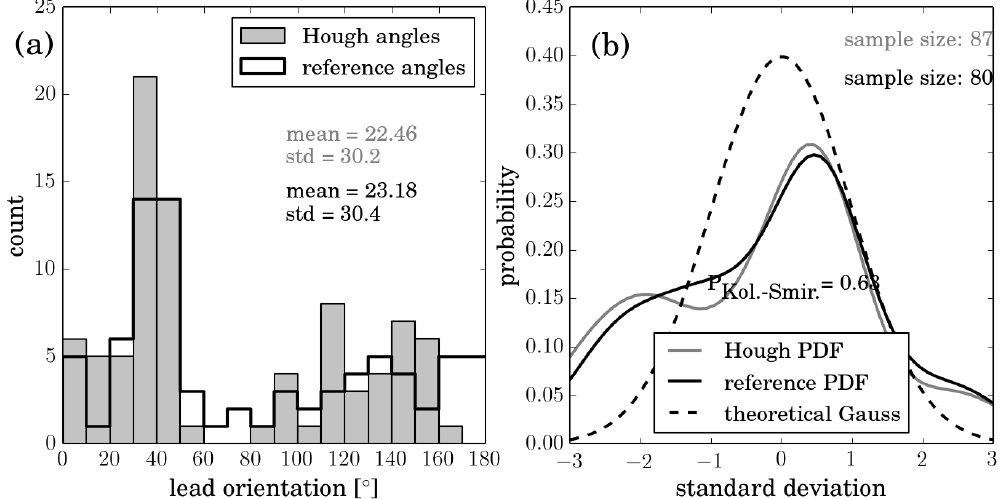
Figure 8. Comparison between lead orientations detected by the Hough transform with reference lead orientations in a histogram ( a ) and as probability density functions ( b ) in the Beaufort Sea on 14 November 2004. The Gauss curve in (b) is shown as